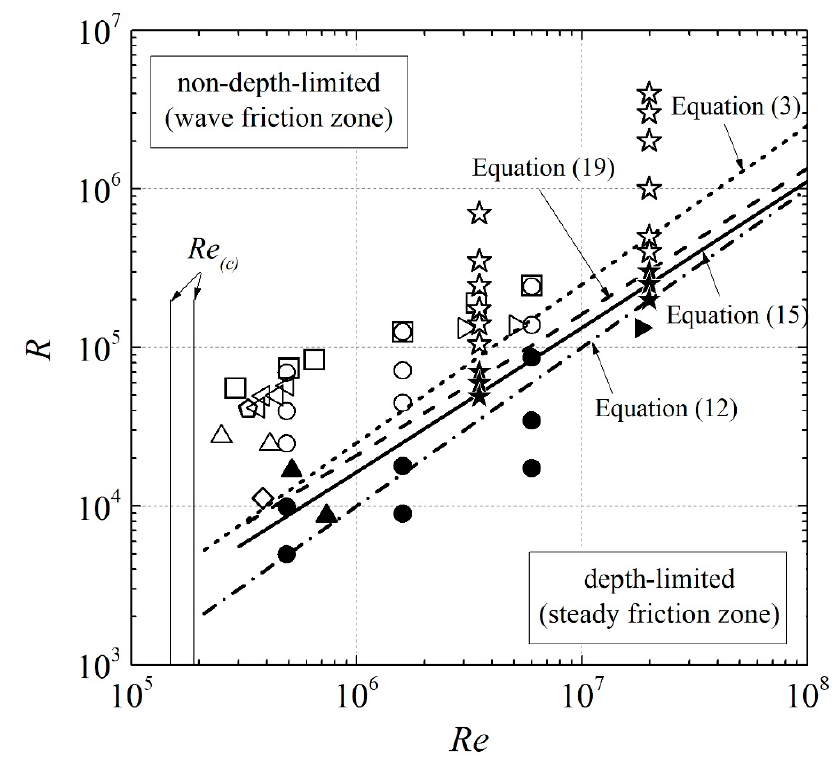
Figure 6. Demarcation in terms of Re and R . For an explanation of symbols see Tables 1 and 2.